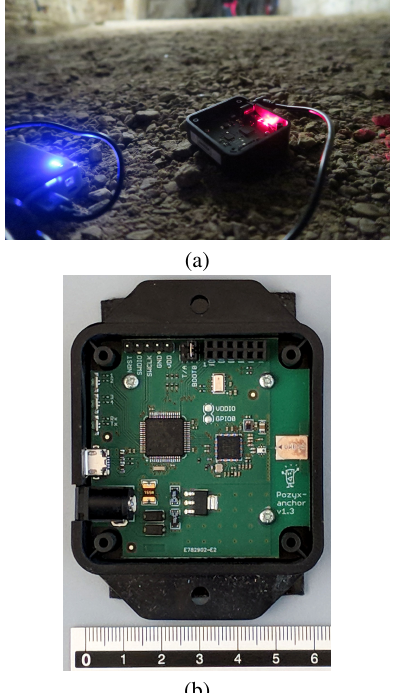
Figure 1. Examples of Pozyx anchor (beside a centimetric ruler in